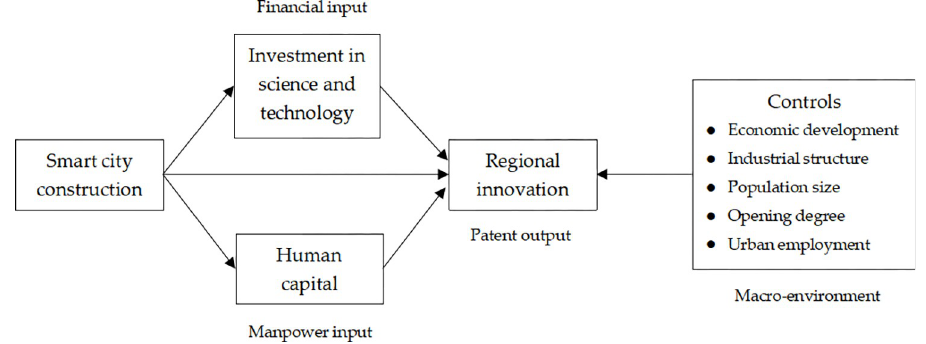
Fig 1. Empirical framework for measuring the impact of smart city construction on regional